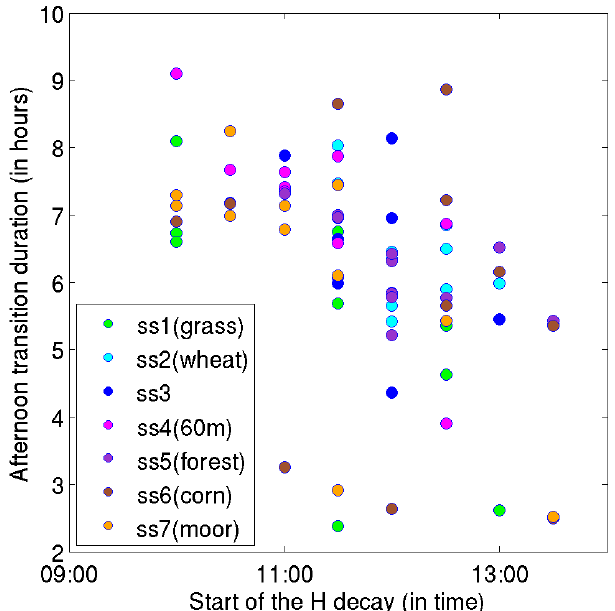
Figure 8. Duration of the afternoon transition as a function of the starting time of the sensible heat flux decay over several surfaces and for all IOP days and sites (colours).